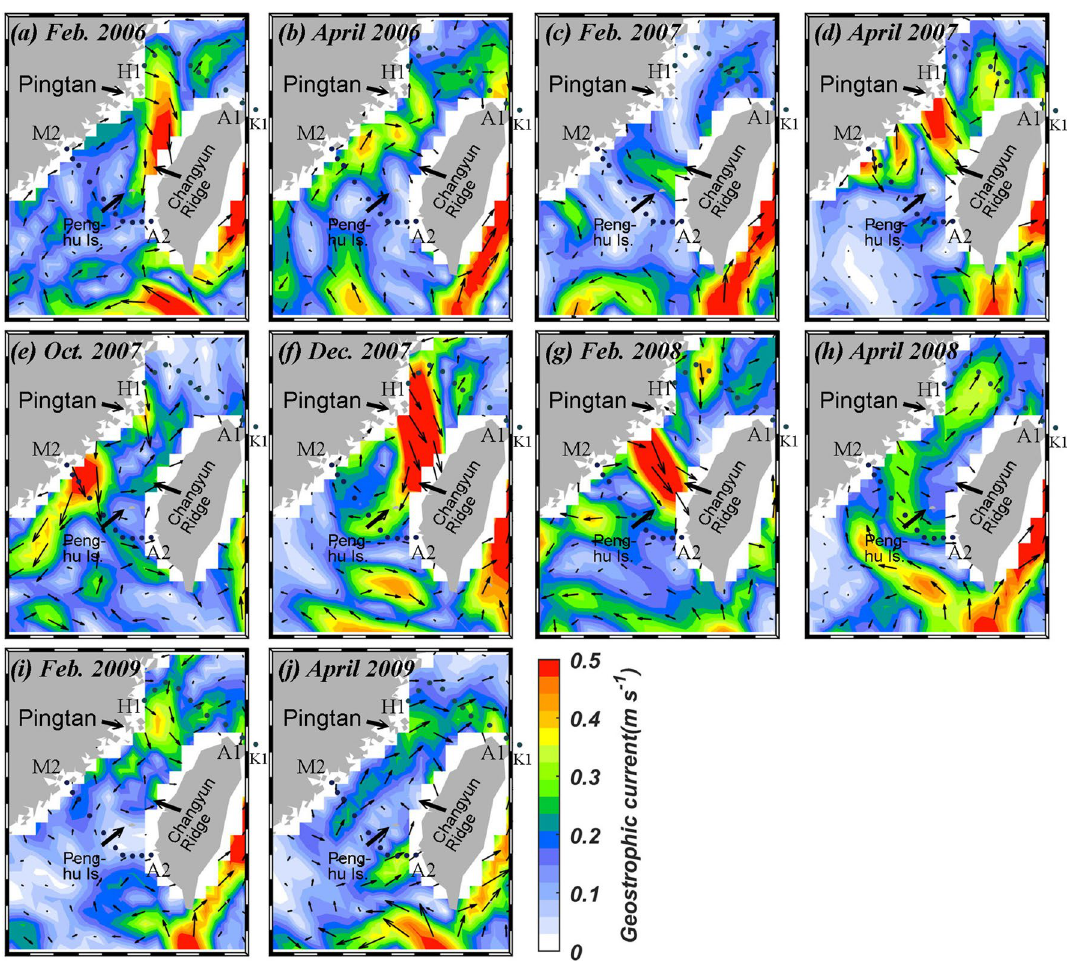
Figure 9. Monthly mean AVISO geostrophic current in ( a ) Feb. 2006, ( b ) April 2006, ( c ) Feb. 2007, ( d ) April 2007, ( e ) Oct. 2007, ( f ) Dec. 2007, ( g ) Feb. 2008, ( h ) April 2008, ( i ) Feb. 2009 and ( j ) April 2009 in the vicinity of the study area (map generated by using the m_map toolbox in MATLAB 2019a; https ://www.mathw orks.com/).